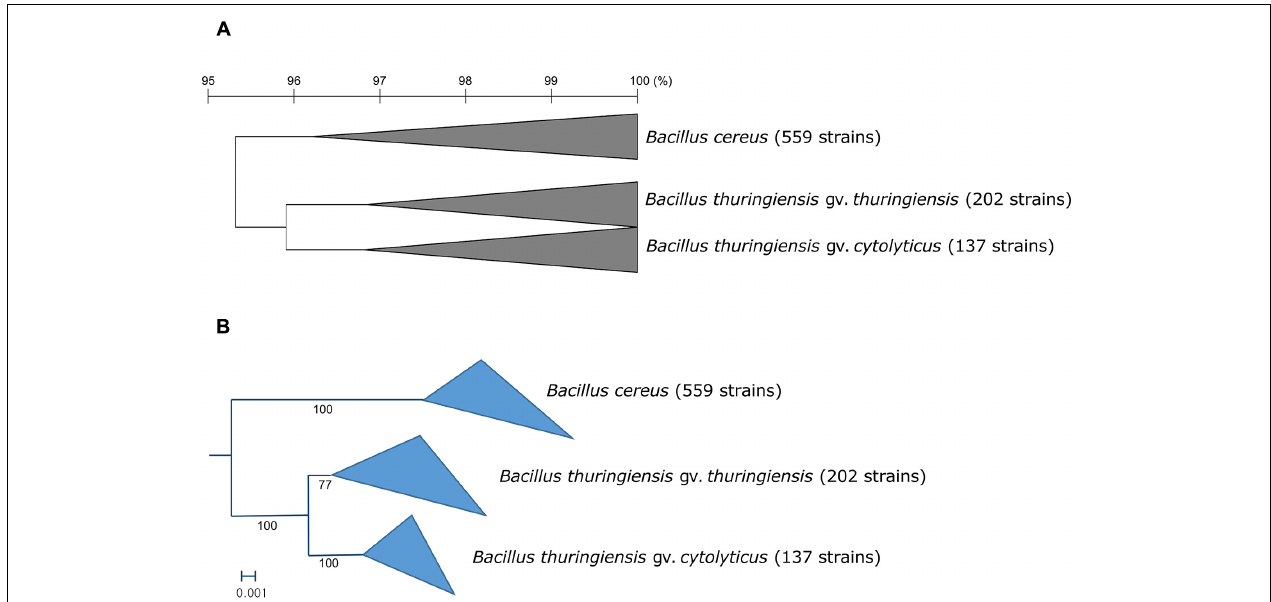
FIGURE 2 | (A) Collapsed OrthoANIu dendrogram and (B) collapsed phylogenomic tree based on 92 universal bacterial genes showing relationships between the three subclades of the B. cereus – B. thuringiensis clade. Bacillus toyonensis BCT-7112 T was used as the outgroup (not shown). The scale bar on the OrthoANIu dendrogram stands for OrthoANIu values (%). Bar on the phylogenomic tree indicates the number of substitutions per nucleotide.